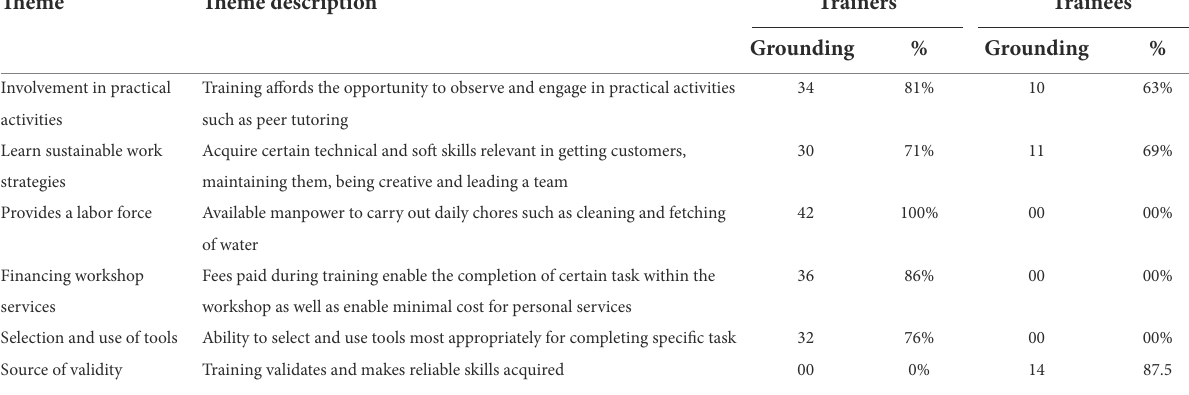
TABLE 2 Perceived strengths of informal training and sustainable livelihoods of unemployed youths.